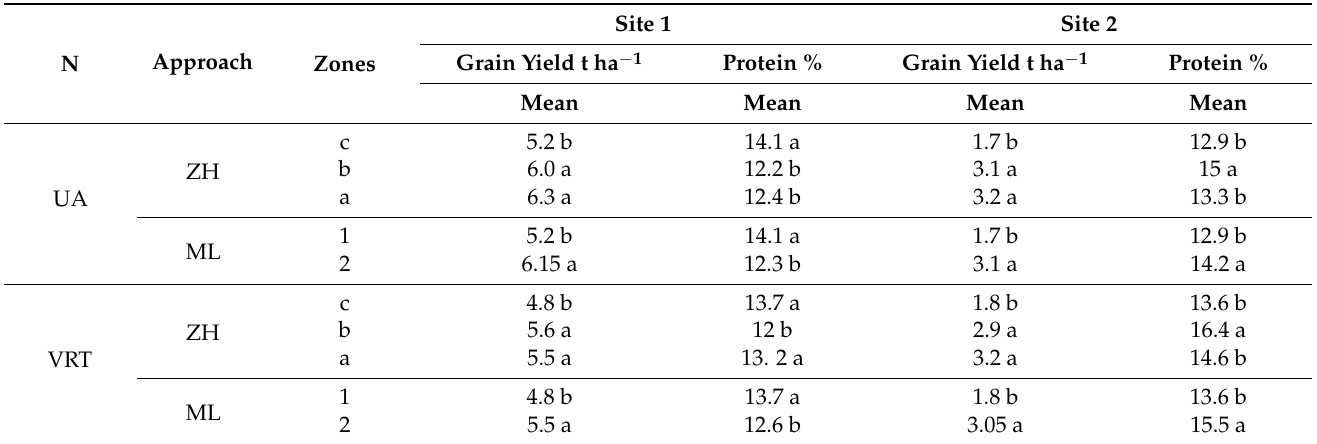
Table 12. Results of the emmeans function applied to the grain yield and protein content based on the zone management experimental factor for both sites.